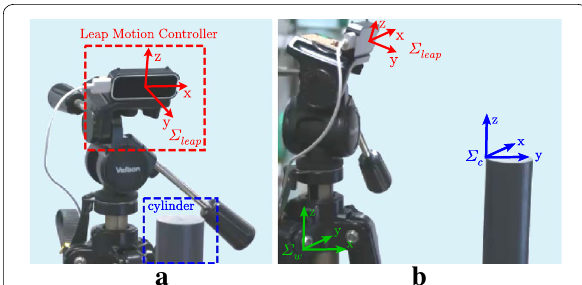
Fig. 2 Experimental setup for tracking the assembly of ring-shaped objects into a cylinder. Front view ( a ) and side view ( b ) of the Leap Motion Controller and the